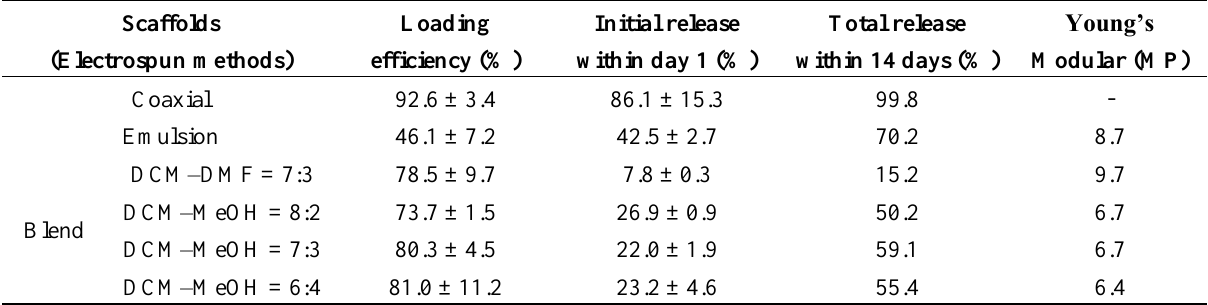
Table 1. Scaffold